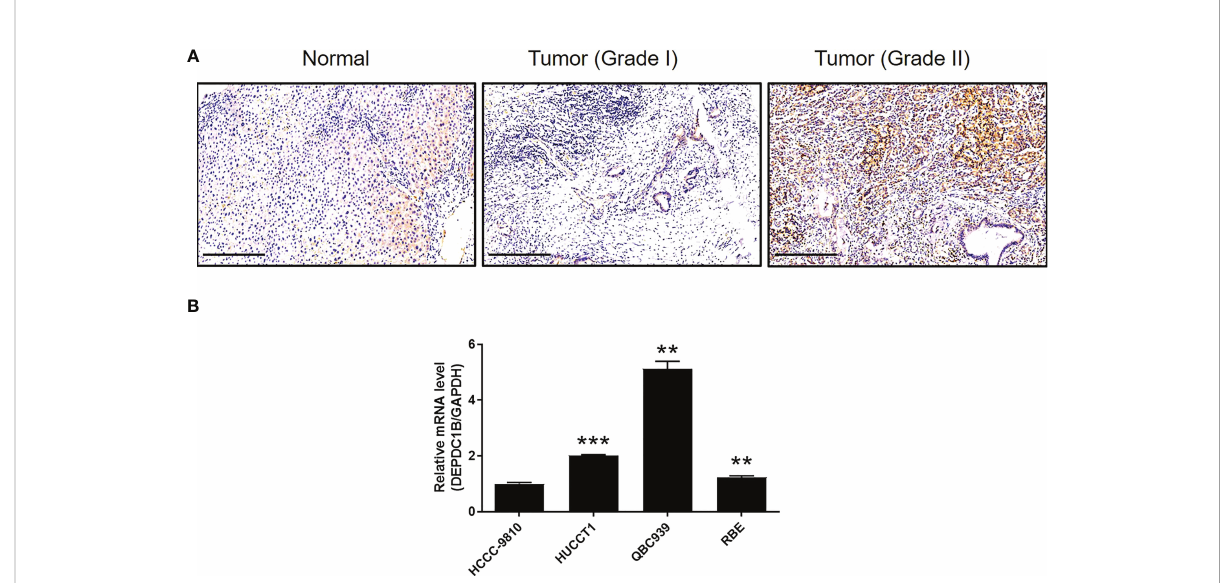
FIGURE 1 DEPDC1B was upregulated in CCA tissues and expressed in CCA cells. (A) The expression level of DEPDC1B was detected by IHC analysis in CCA tissues and normal tissues (scale bar = 250 m m). (B) The mRNA expression of DEPDC1B in HCCC-9810, HUCCT1, QBC939, and RBE cell lines was detected by qPCR. Data were shown as mean ± SD (n = 3). ** P < 0.01, *** P <